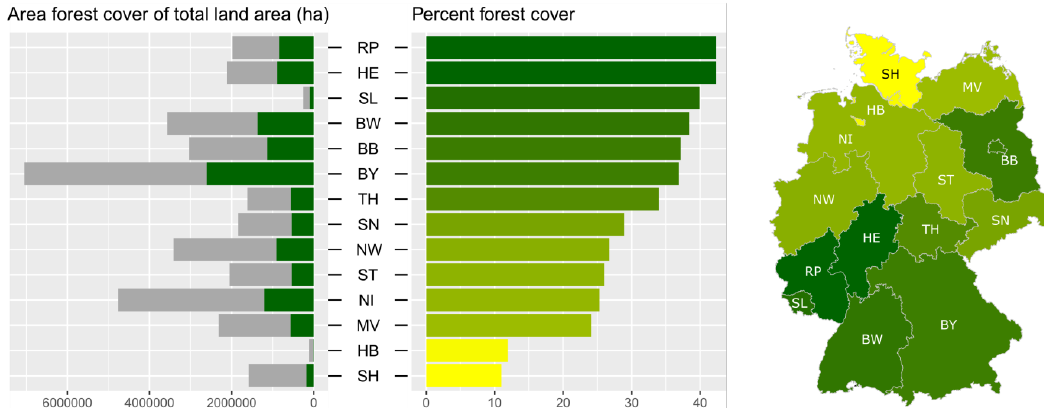
Figure 2. Forest cover in Germany ( a ) and elevation distribution of forest compared to Germany ( b ). Data source: Forest cover is taken from the DLM250 ( Digitales Landschaftsmodell digital landscape model 1:250,000). The elevation histograms are based on TanDEM-X data with 90-m spatial resolution.